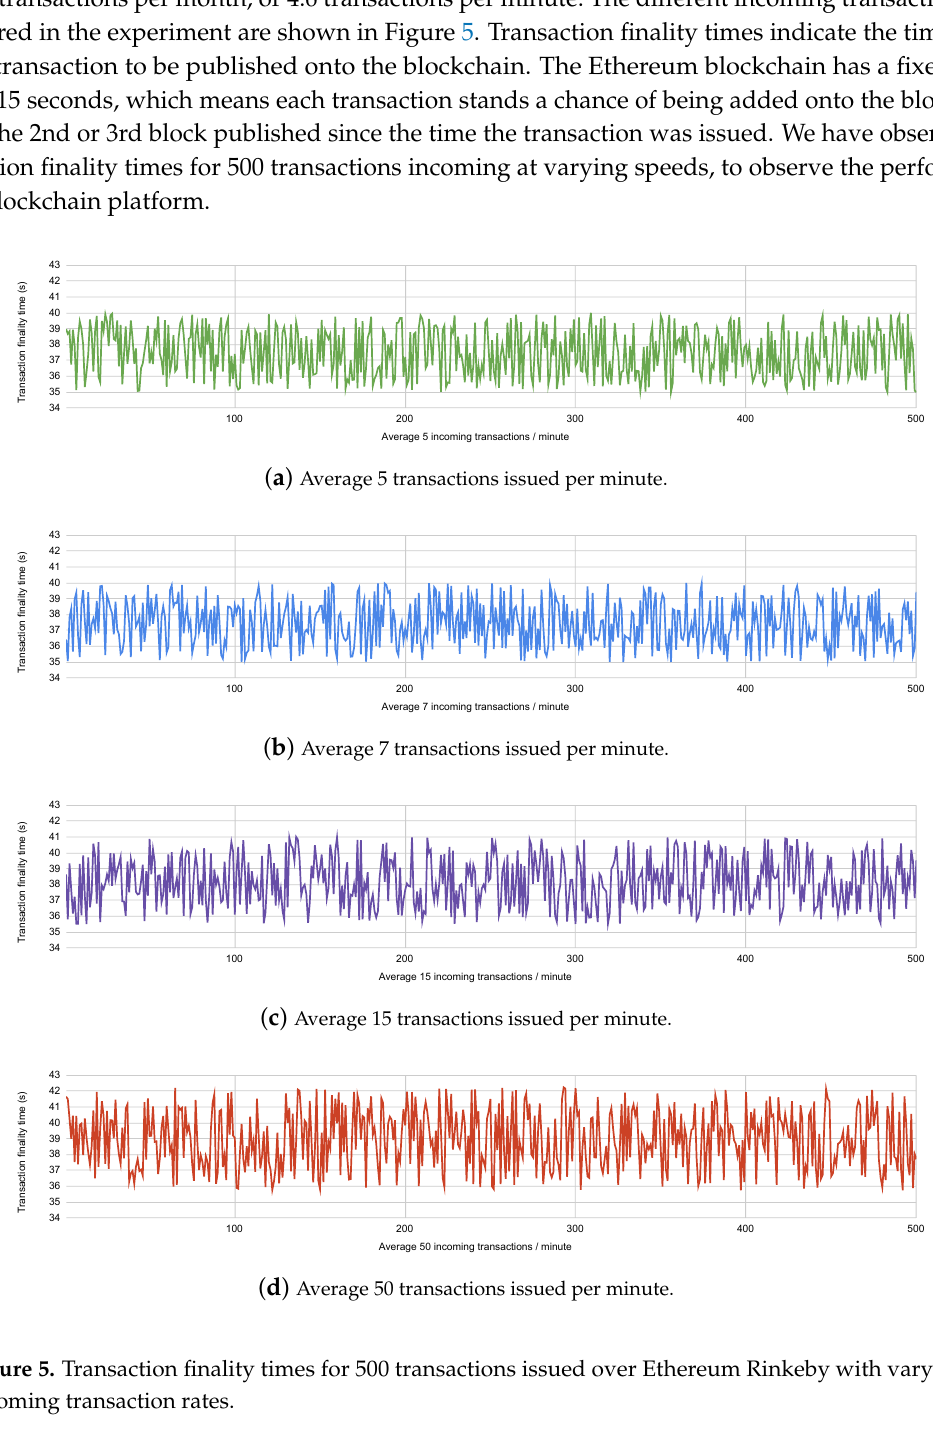
Figure 5. Transaction finality times for 500 transactions issued over Ethereum Rinkeby with varying incoming transaction